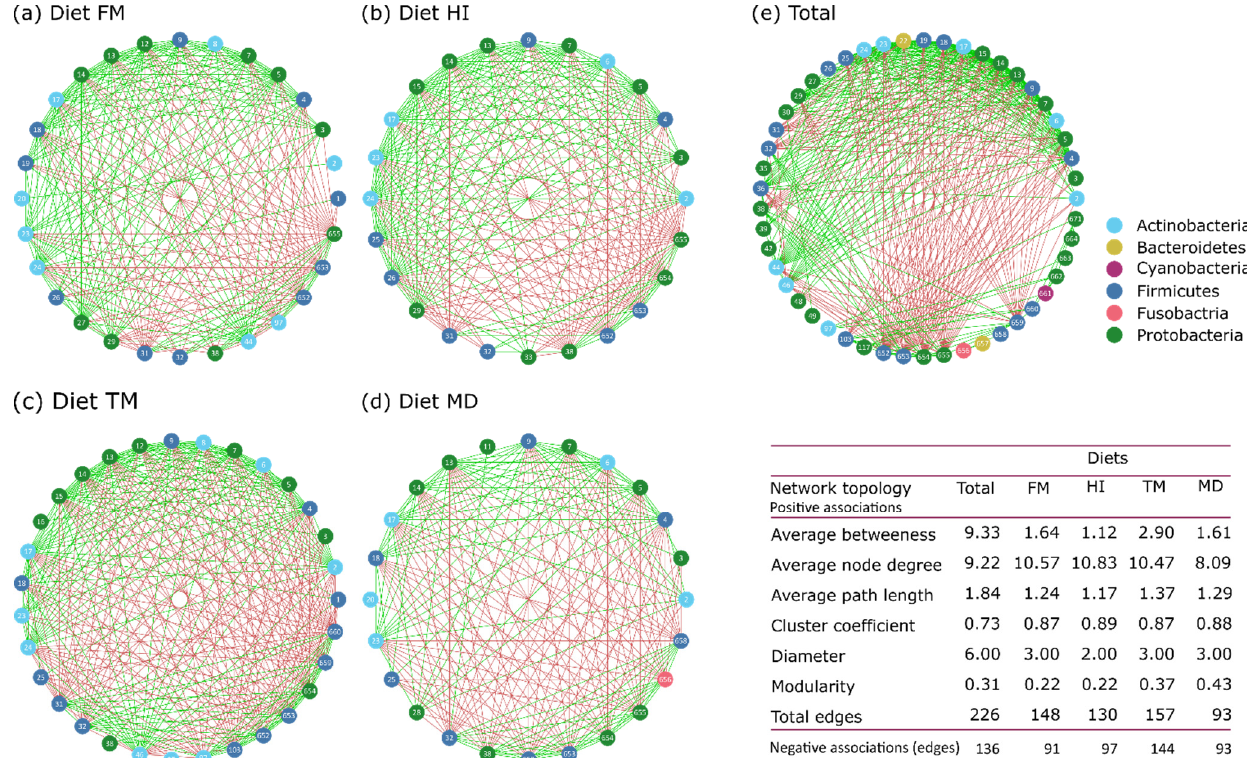
Figure 7. Empirical microbial networks describing the co-occurrence patterns and interactions between bacterial genera in the regime of the four dietary treatments ( a ) FM, ( b ) HI, ( c ) TM, and ( d ) MD based on OTUs derived from the gut of both Dicentrarchus labrax and Sparus aurata , in addition to a general network ( e ) based on all samples. Each node in the network signifies one bacterial OTU and each edge indicates significant interactions among the nodes, based on Spearman's correlations (r > 0.7, p < 0.001). The green colored edges represent positive interactions and the red colored edges represent negative interactions. Colors of the nodes represent the phylum assigned to each node and are described in the legend. The major topological features of the respective networks are presented in the table. Abbreviations according to Figure 1.